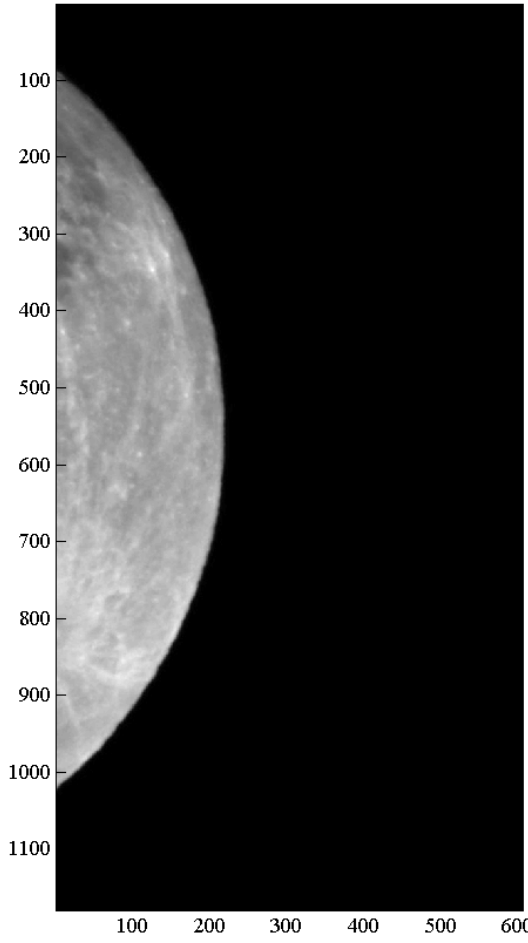
Figure 15. Example 3: Original